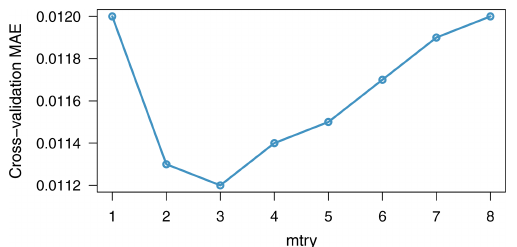
Figure 5. Out-of-bag mean absolute error plotted against mtry during an optimal parameter search at the Carbon River Watershed (USGS site